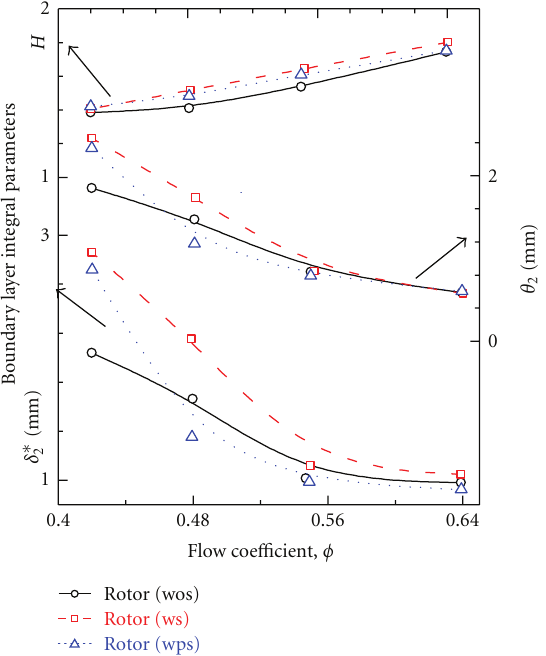
Figure 9: Variation of boundary layer integral parameters with flow coe ffi cient at the rotor